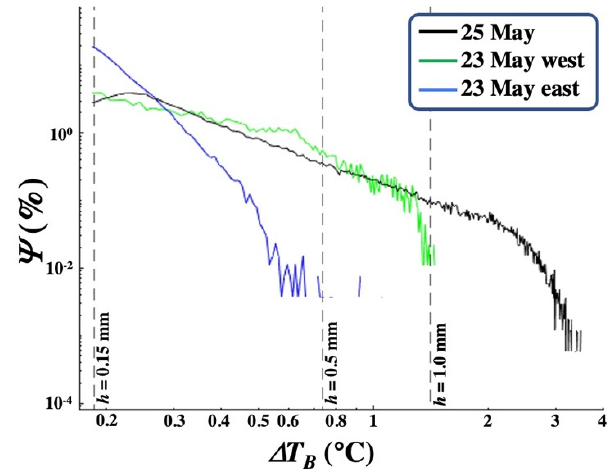
Figure 12. Brightness temperature contrast, Δ T B , probability distribution, ψ , for 23 and 25 May for several cutoff thicknesses, h , shown by dashed vertical lines. Data key on figure. See Figure 10A for the east and west slicks on 23 May.